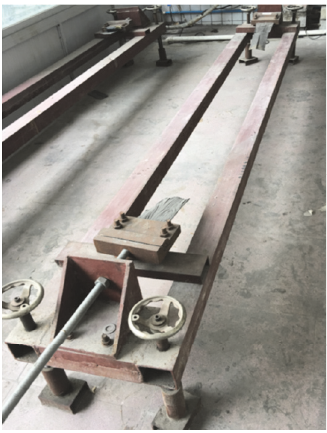
Figure 3: Photo of prestressing